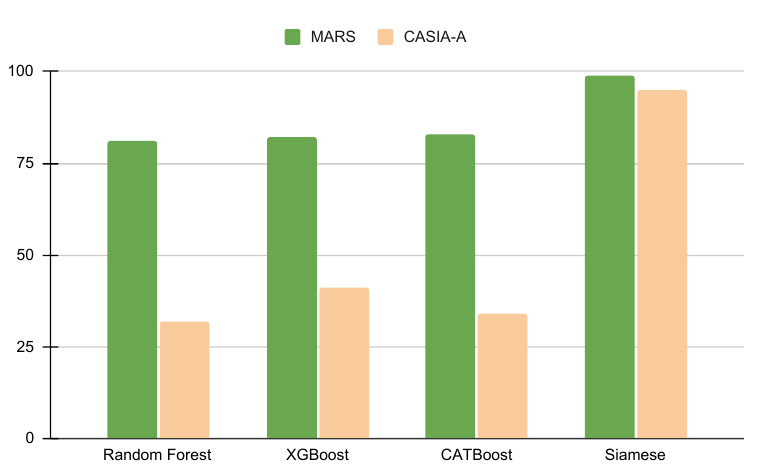
Figure 17. The performance of classifiers accuracy for the MARS and CASIA-A datasets.